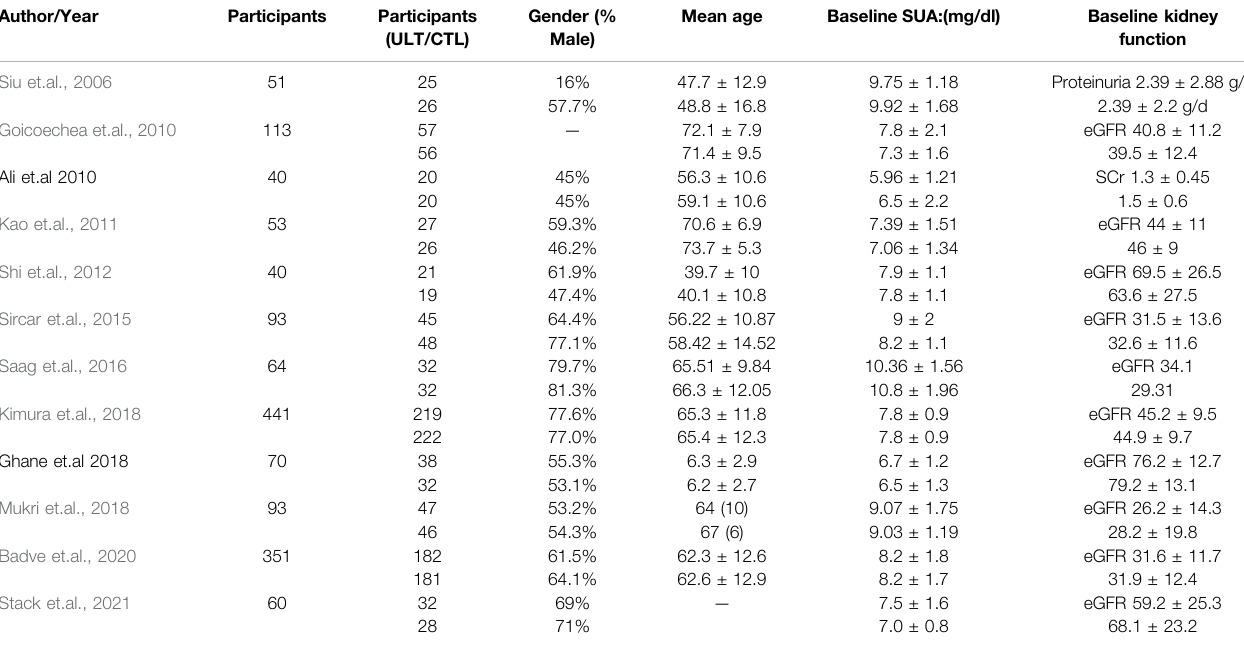
TABLE 2 | Baseline characteristics of included